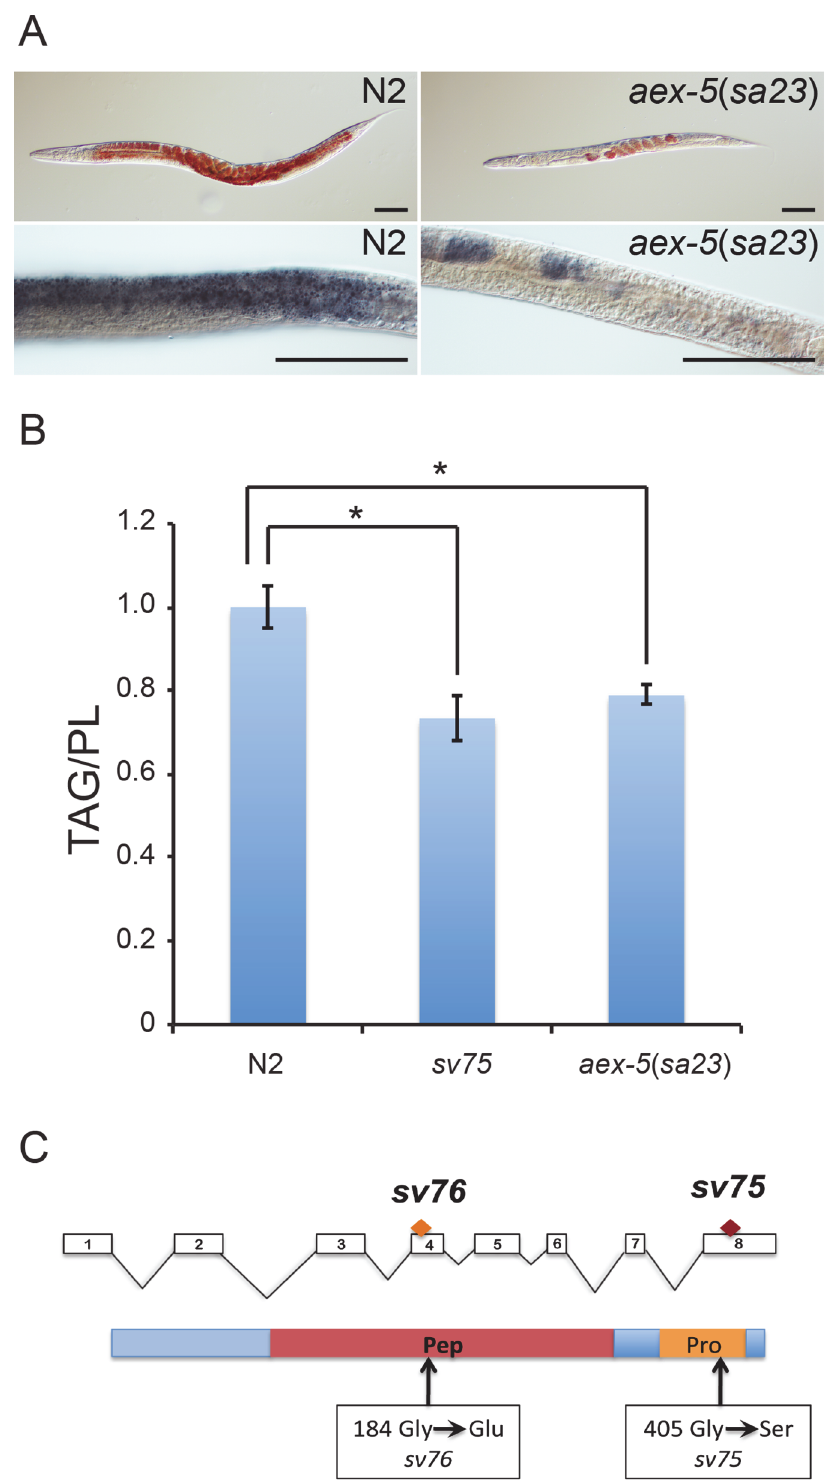
Fig 3. sv75 and sv76 are alleles of aex-5 . A. Micrographs of fixed young adult hermaphrodites stained with Oil Red O (top panels) or Sudan Black (bottom panels). In wild-type (N2) worms, the dyes stain the intestine and the oocytes within the gonad. In the aex-5 ( sa23 ) mutant, only the oocytes show significant staining. Scale bars are 10 μ m. B. Graph showing triglyceride/phospholipid ratios determined by gas-liquid chromatography.